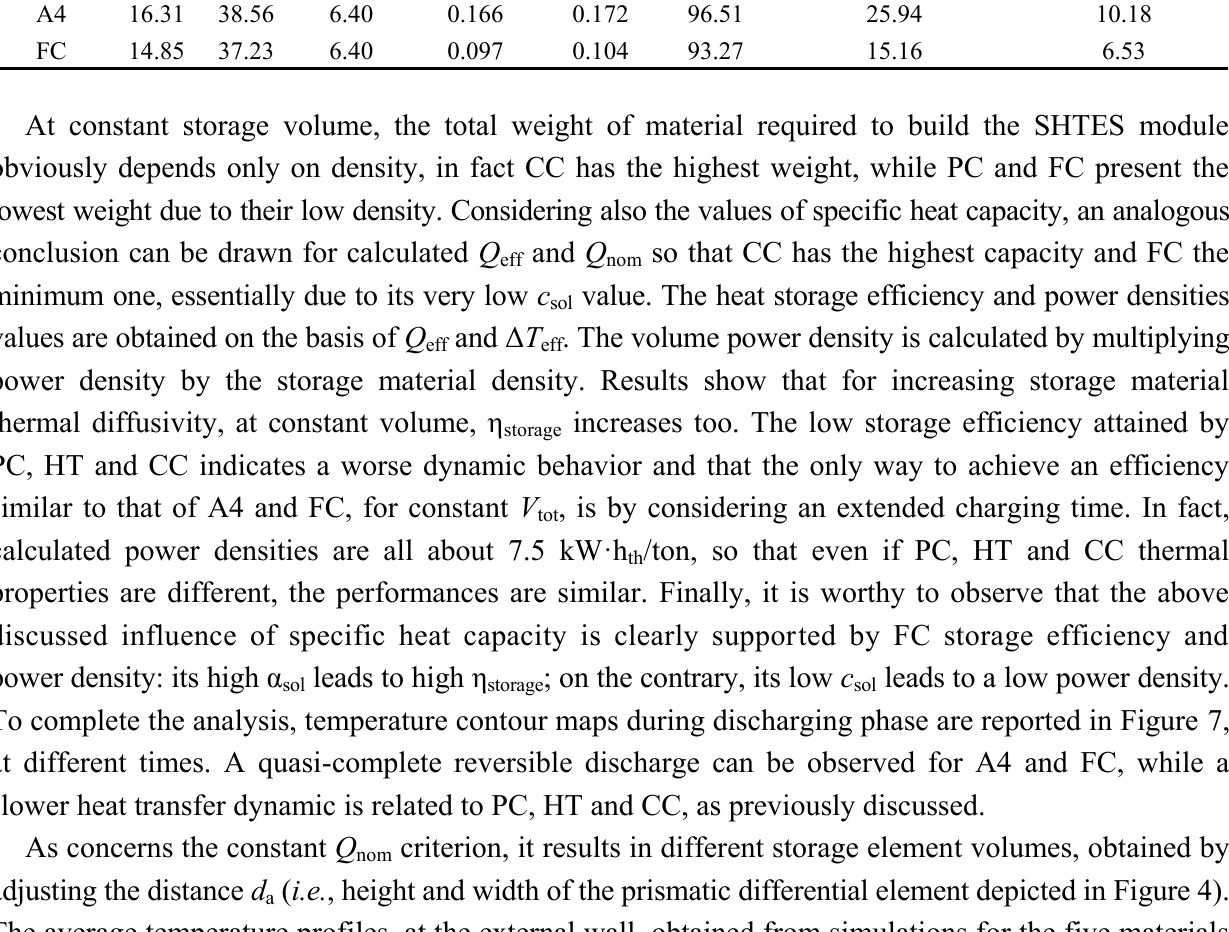
Table 4. Analysis results at constant V